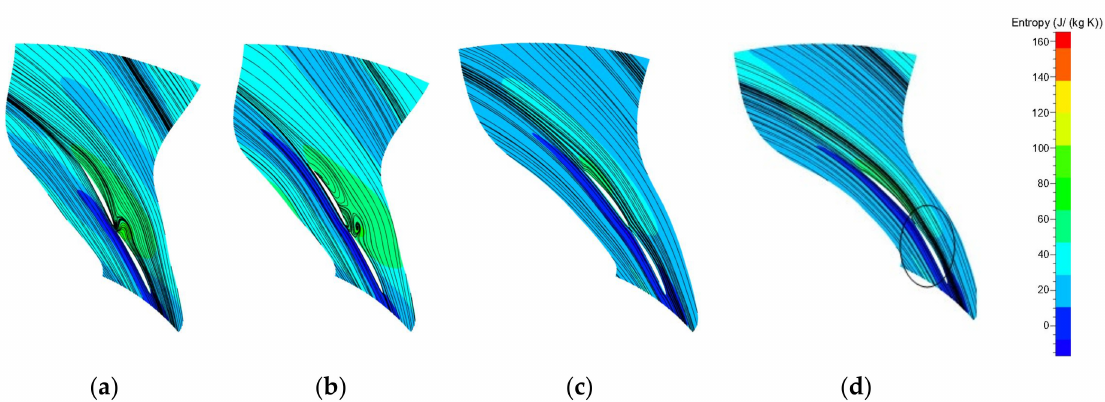
Figure 12. Entropy and streamline distribution at 50% span in different cases. ( a ) 0 ◦ model; ( b ) 3 ◦ model; ( c ) 10 ◦ model; and ( d ) 18 ◦ model.